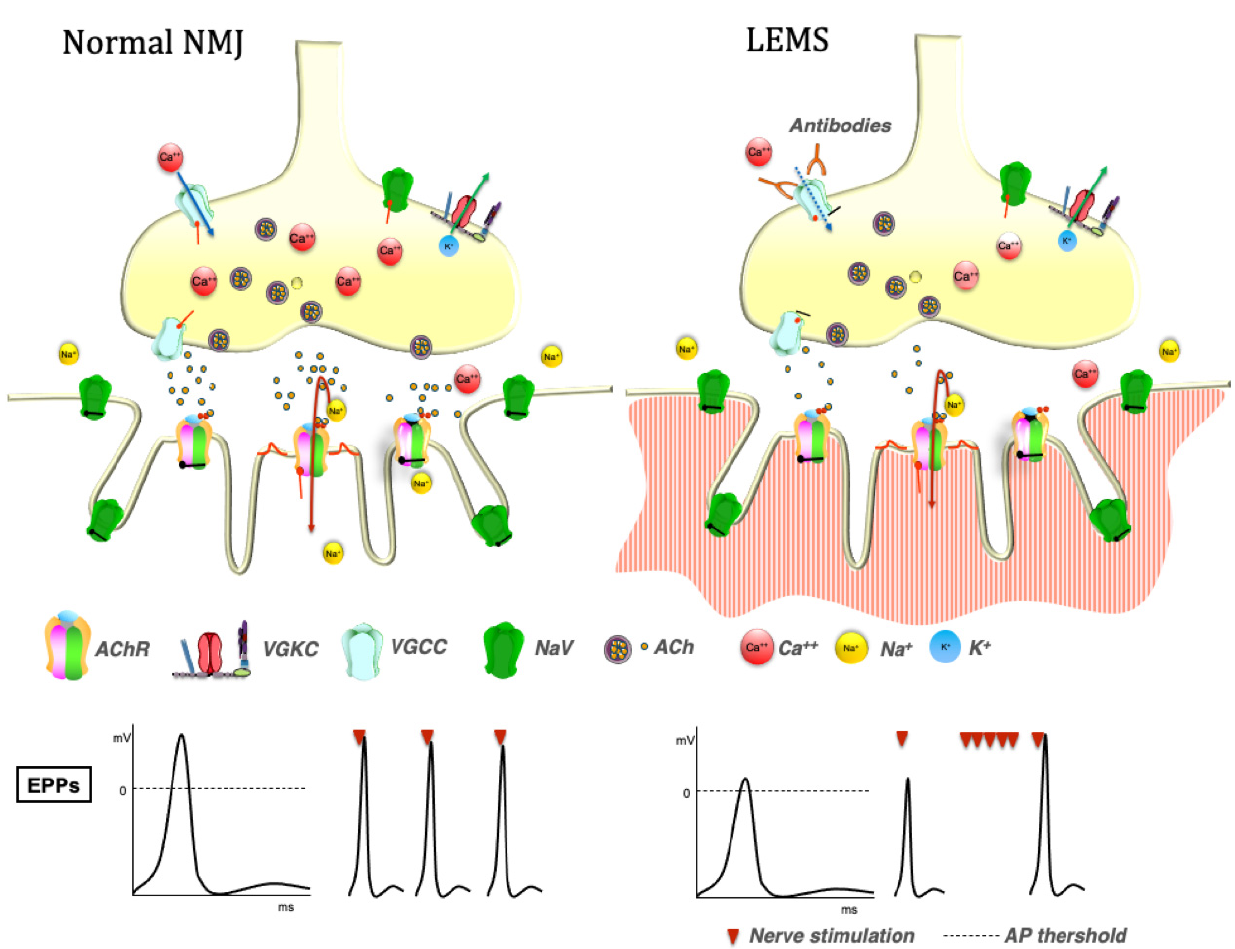
Figure 1. Pathophysiology of LEMS. In normal conditions, the depolarization of the presynaptic nerve terminal leads to calcium ions influx, acetylcholine (ACh) release, and binding to the ACh receptors (AChR) with a consequent influx of positively charged ions, mainly sodium, generation of an endplate potential (EPP) and muscle contraction. In LEMS, voltage gated calcium channel (VGCC) antibodies block calcium influx causing a reduction of the ACh released at the presynaptic terminal with consequent reduction of the EPP amplitude. High-frequency repetitive nerve stimulation however can increase the EPP amplitude through calcium accumulation in the presynaptic terminal and increased ACh release.